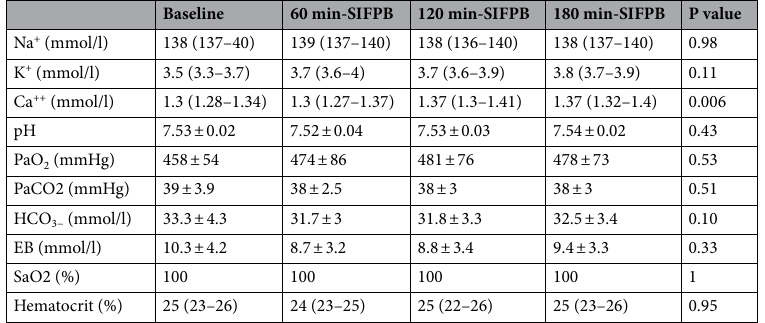
Table 1. Biologic parameters at baseline, 60, 120 and 180 post-serratus intercostal fascial plane block. Data are showed as medians interquartile range (IQR) for non-normally distributed data using the Shapiro–Wilk test, and as means ± standard deviation for normally distributed variables. SIFPB serratus intercostal fascial plane